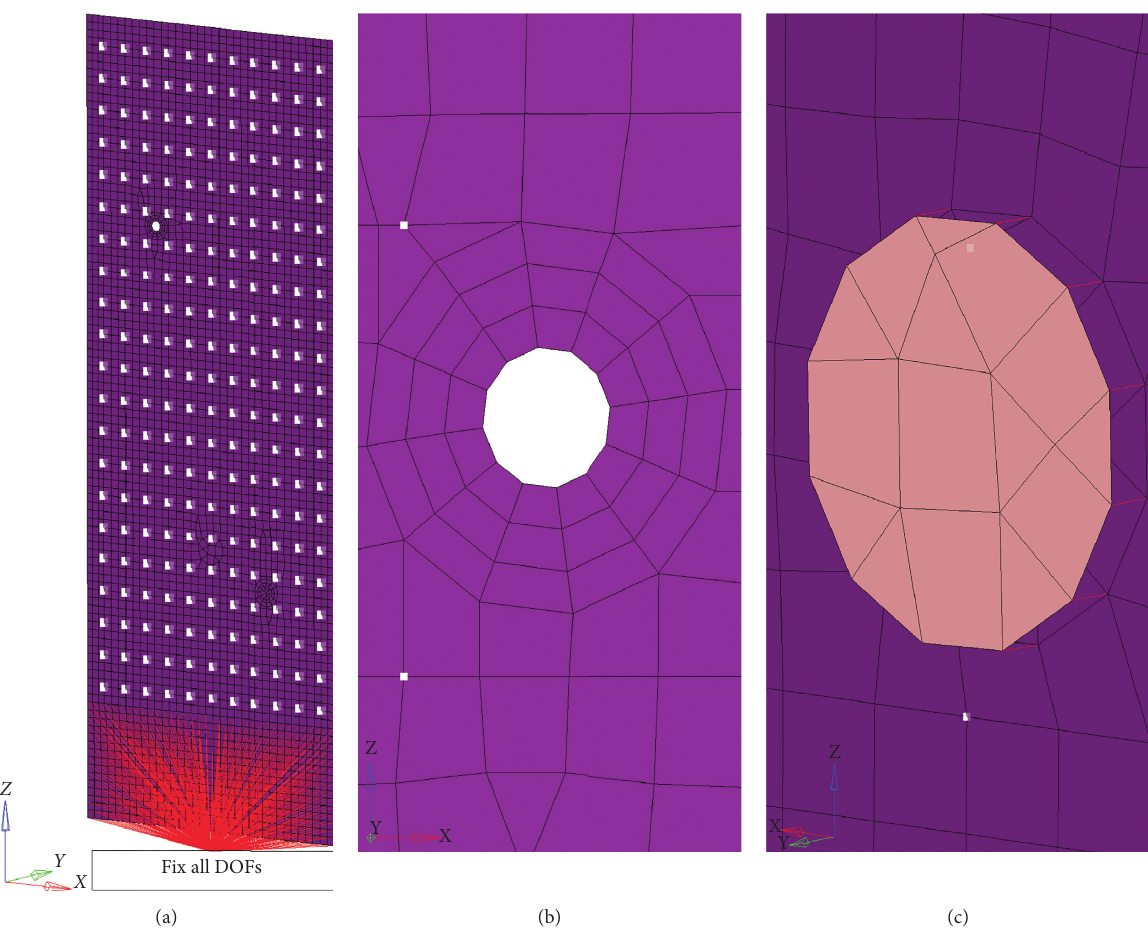
Figure 5: (a) FEM model. (b) Detail of mesh around the damage. (c) Detail of mesh in excitation